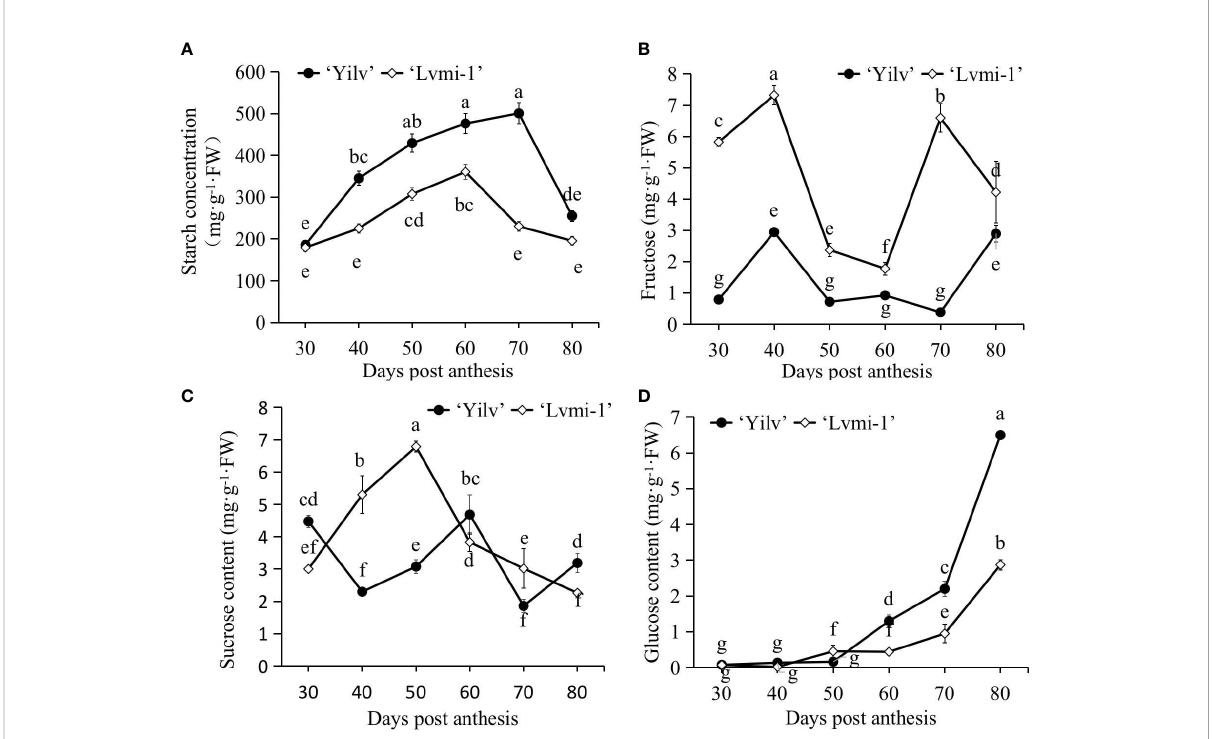
FIGURE 5 Changes in sugar and starch content of ‘ Yilv ’ and ‘ Lvmi-1 ’ fruit during fruit development and maturity. (A) Starch content. (B) Fructose content. (C) Sucrose content. (D) Glucose content. FW, fresh weight. Data were represented by the mean values ± standard deviation. Different letters indicated signi fi cant difference at the p ≤ 0.05